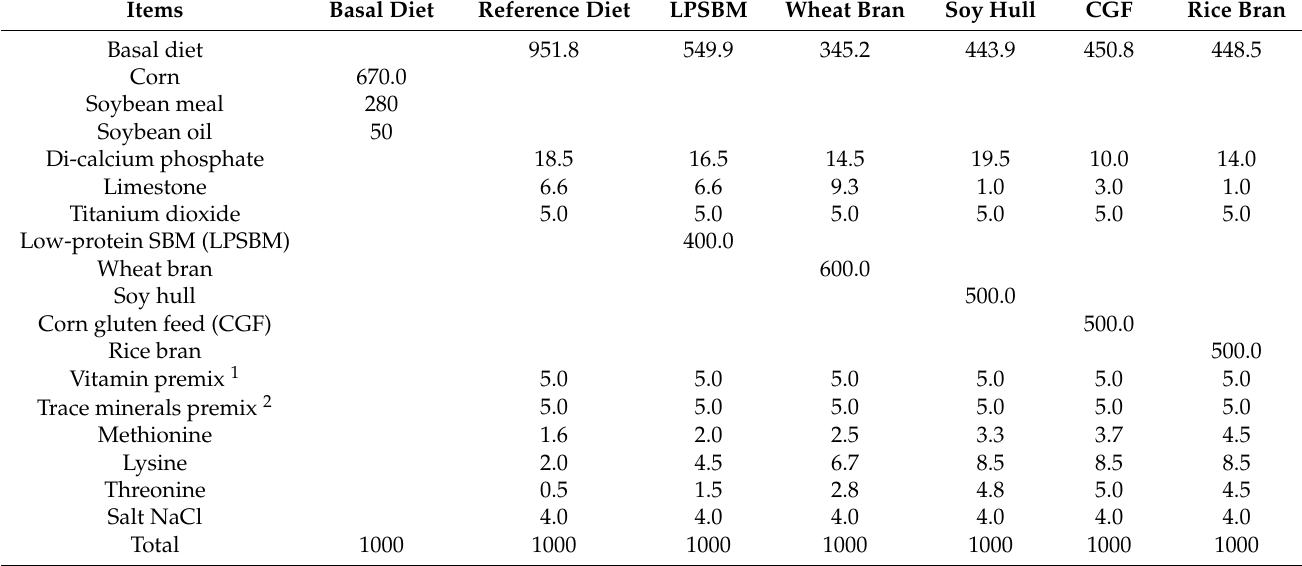
Table 2. Feedstuff and nutritional composition (g/kg as fed) of experimental